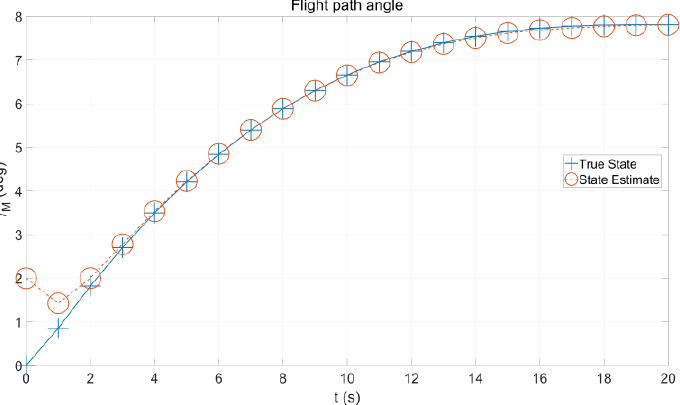
Figure 9. Trajectory of the relative distance and corresponding estimates.